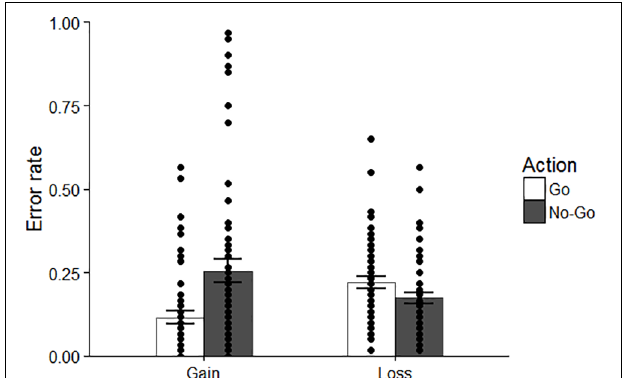
FIGURE 5 | Behavioral performance in Experiment 2. Individual data are displayed by dots. Error bars represent standard